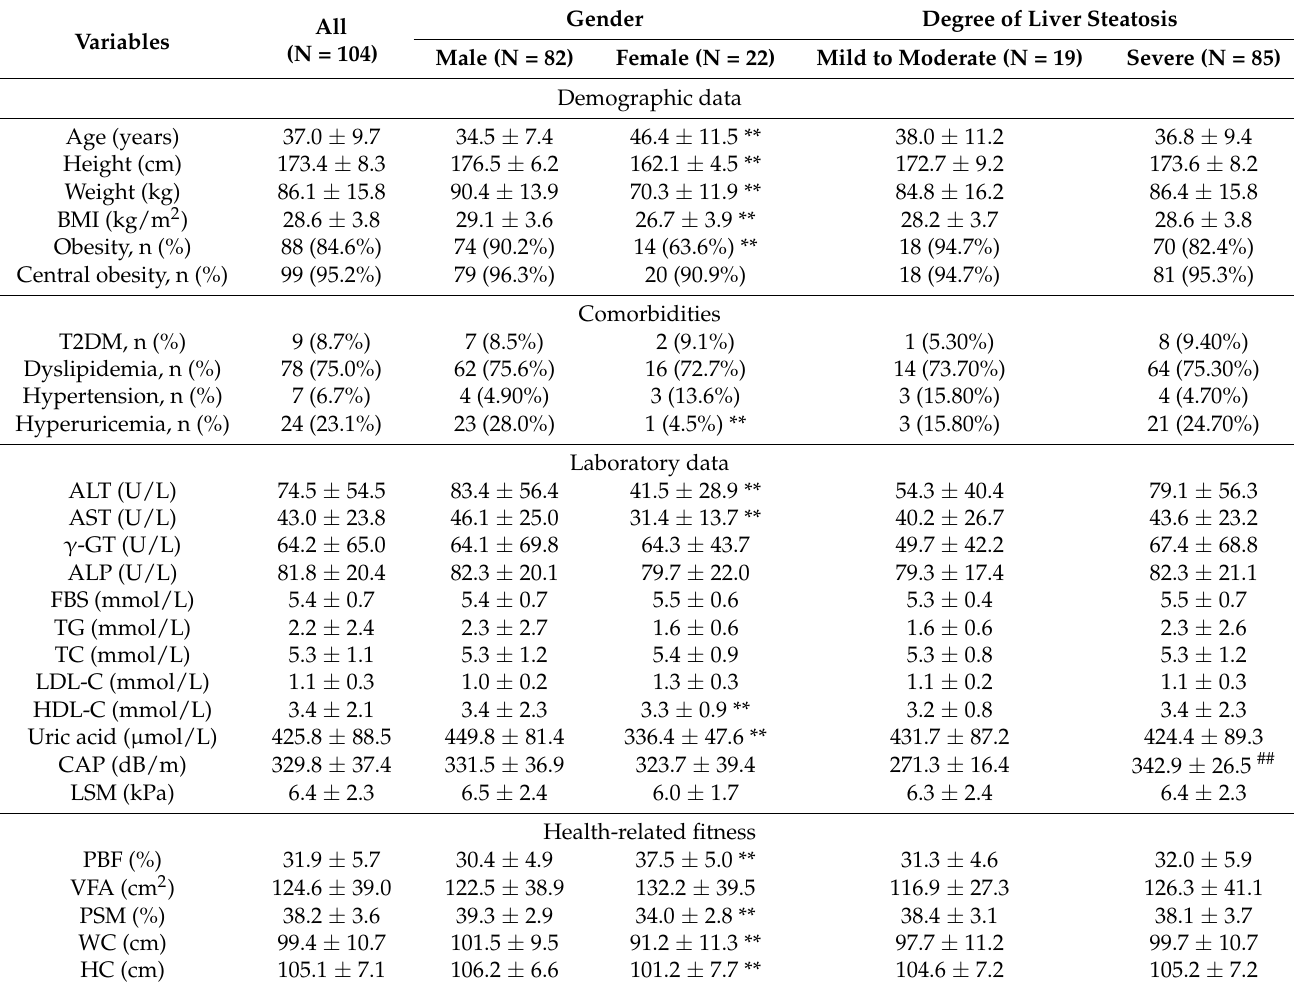
Table 1. Characteristics of patients with